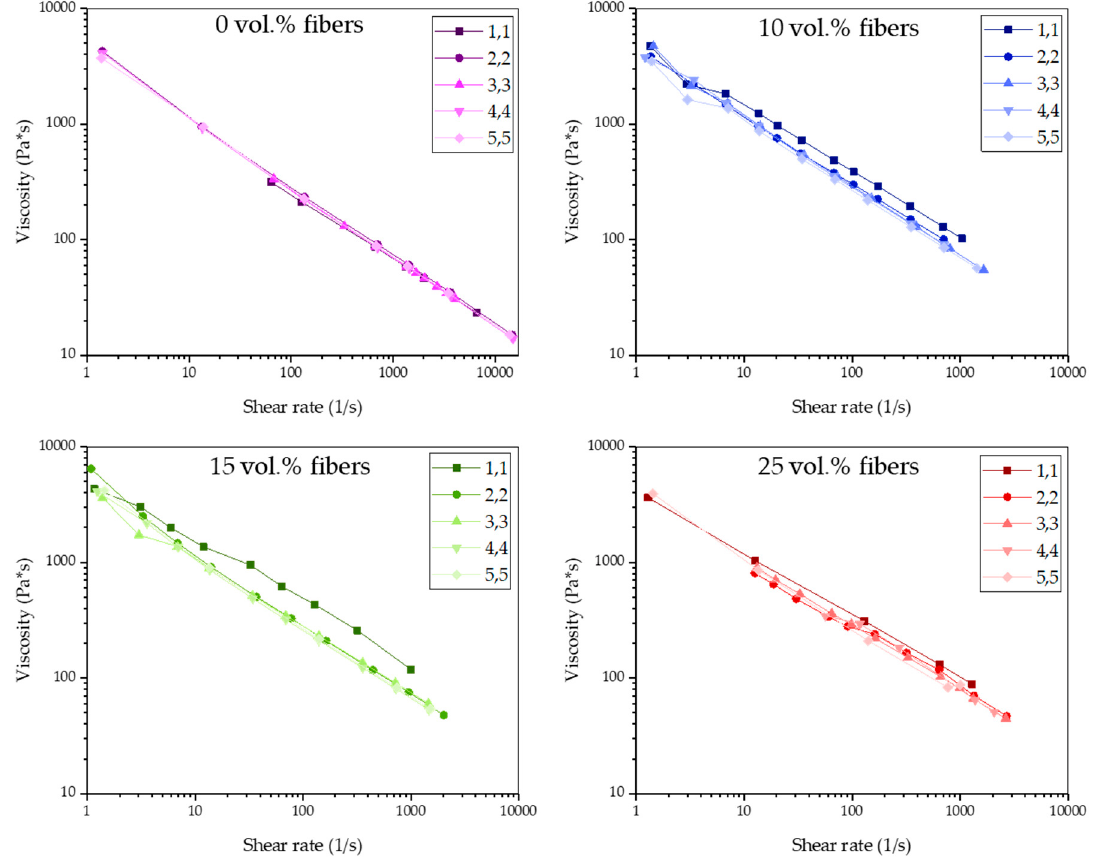
Figure A3. Separate representation of the viscosities of different feedstocks with increasing fiber content and stearic acid.